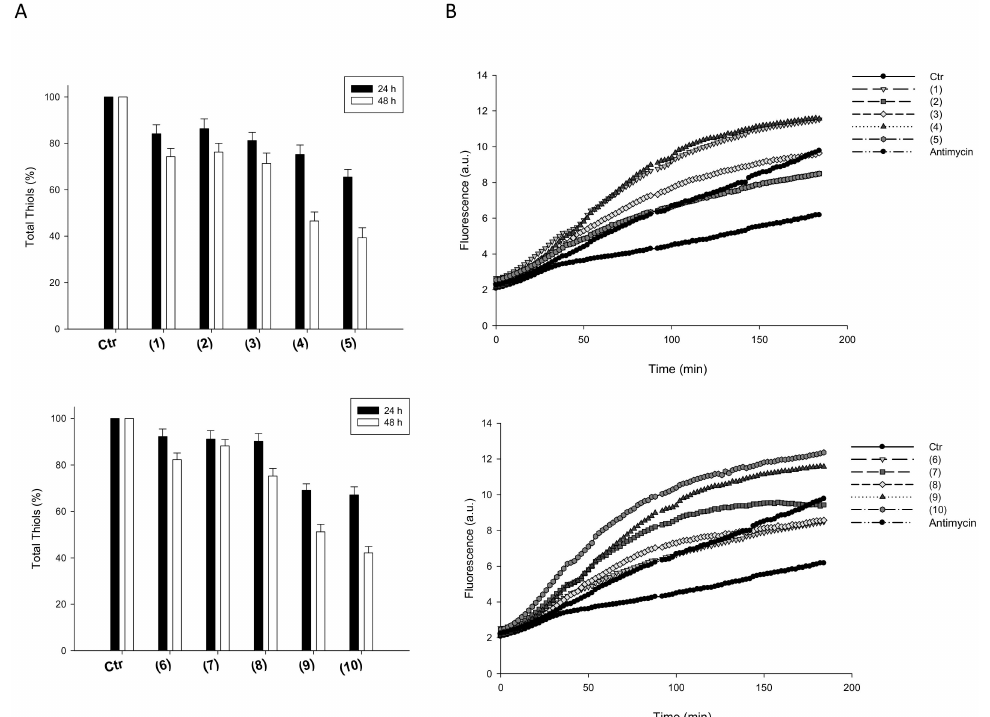
Figure 5. Cellular total thiol state and ROS production. ( A ) Sulfhydryl content in 2008-treated cancer cells incubated for 24 h or 48 h with tested silver(I) compounds. The sulfhydryl group amount was determined by the DTNB assay. Error bars indicate S.D. ( B ) e ff ect of silver(I) compounds on hydrogen peroxide formation in 2008 cells. 2008 cells were pre-incubated in PBS / 10 mM glucose medium for 20 min at 37 ◦ C in presence of 10 µ M CM-DCFDA and then treated with IC 50 of silver(I)